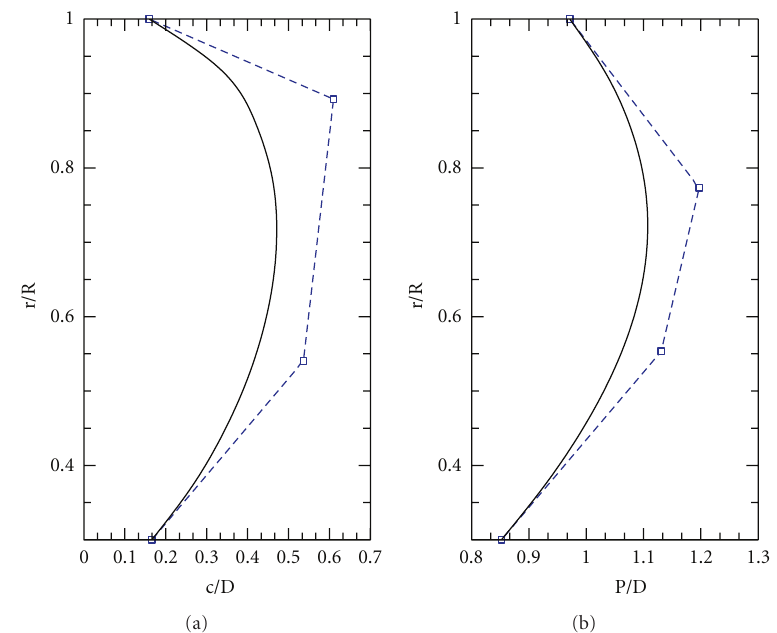
Figure 4: B-Spline representation of radial distributions of chord and pitch.